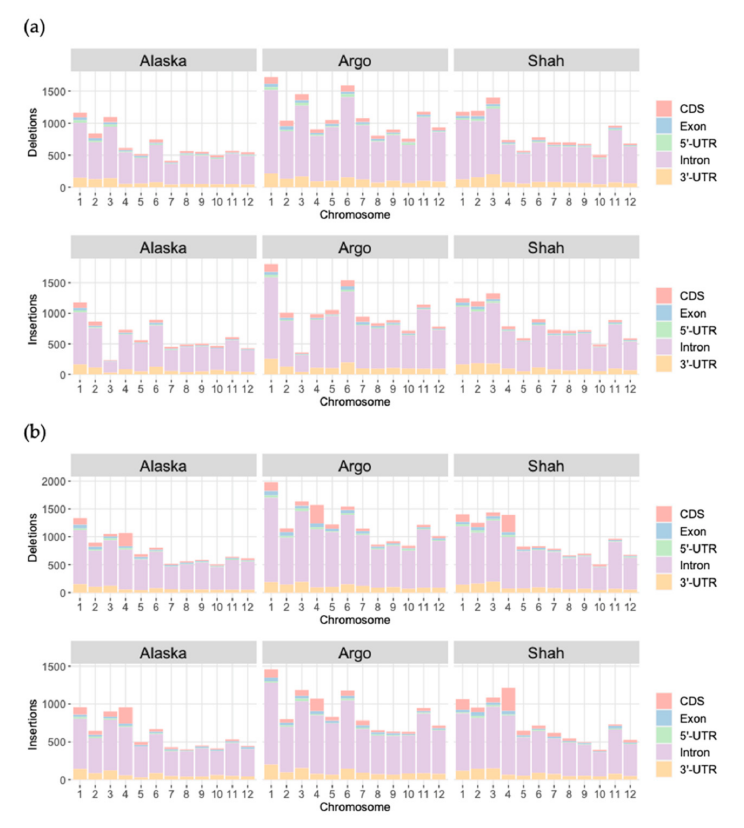
Figure 2. The numbers of structural variants identified by ( a ) SVIM and ( b ) Sniffles algorithms. Large deletions and duplications (2.5 kbp–55 Mbp) identified by Sniffles affect whole genes and their clusters. Indels leading to duplications or deletions of one to two genes are more frequent, but their total contribution to the change in the number of copies is much lower than that of SVs longer than 100 kbp. (Table 5). We identified the encoded proteins or protein families for some deletions and duplications (Table S1). For example, dehydration-responsive protein (protein of drought stress [39]), ubiquitin-related protein (resistance to pathogens, response to abiotic stress [40]), polygalacturonase inhibiting protein (resistance to pathogens [41]), and β -fructofuranosidases (which play a role in the cold-induced sweetening of potato tubers [42]) were duplicated. In contrast, some of the nucleic acid synthesis-related proteins, metabolic enzymes and no apical meristem (NAM) protein (protein of salt and heat stress, resistance to P. infestans [43]) were